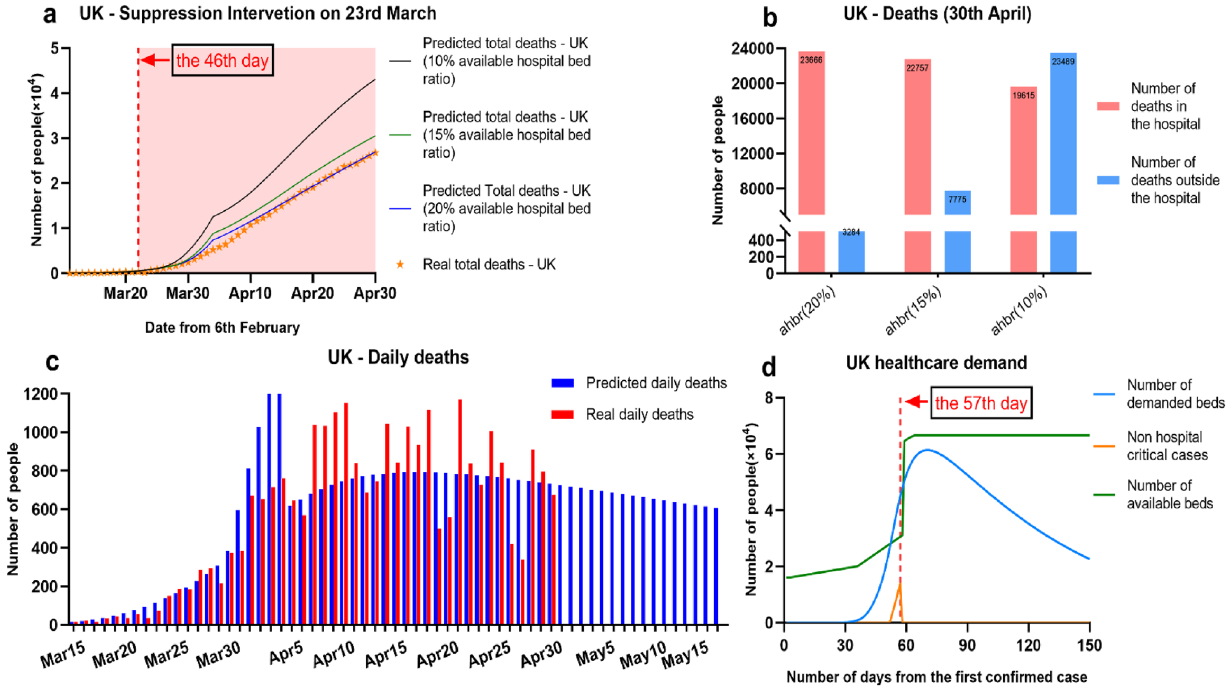
Figure 2. Predicting the impact of Suppression intervention on the UK healthcare demand: ( a ) Forecasting COVID-19 daily deaths in the UK with varied ratio of available hospital bed; ( b ) Forecasting COVID-19 hospital and non-hospital deaths with varied ratio of available hospital bed; ( c ) Demonstration of our predicted daily deaths and real daily deaths by April 30; ( d ) Demonstration of change of the UK healthcare demand over